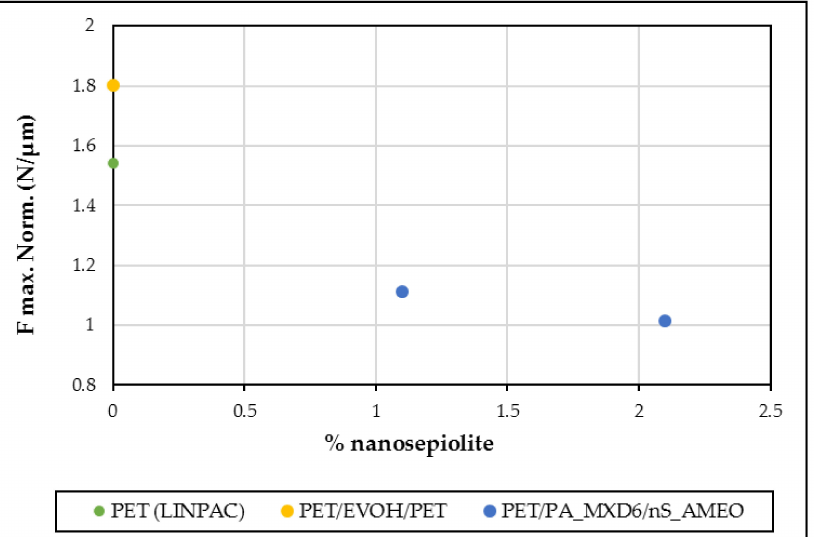
Figure 10. PET/PA_MXD6/nS_AMEO nanocomposites Normalized maximum force as a function of nanosepiolite content.